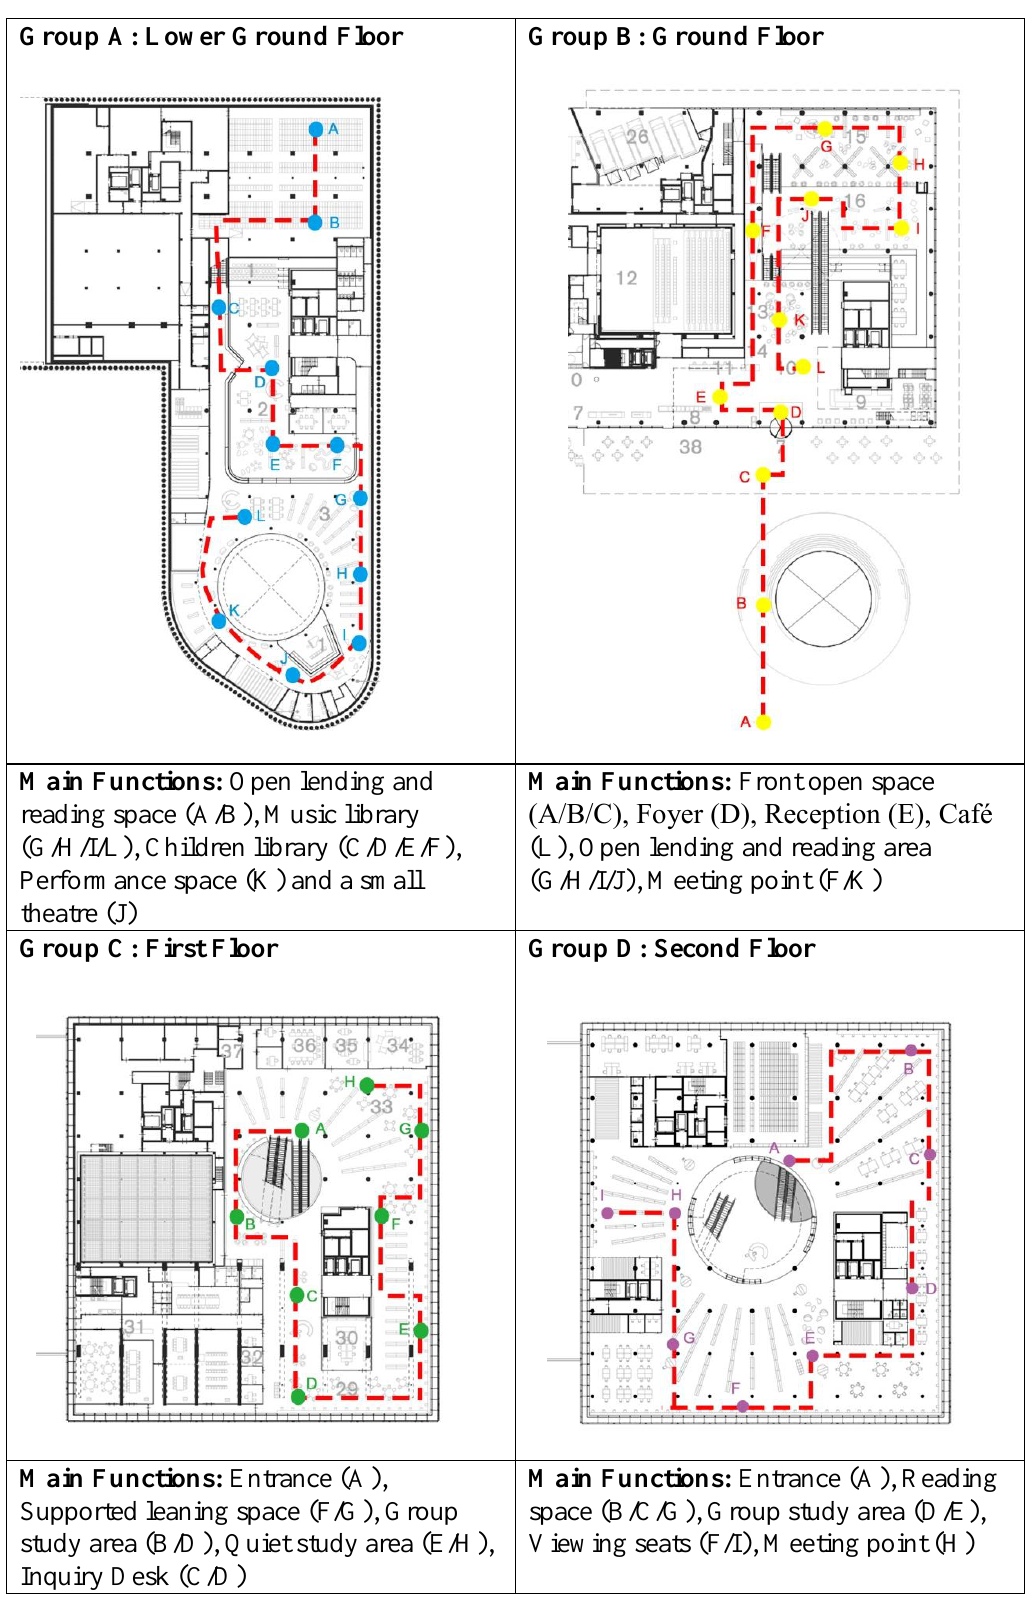
Figure 2: Route descriptions of soundwalks taken at four levels in the Library of